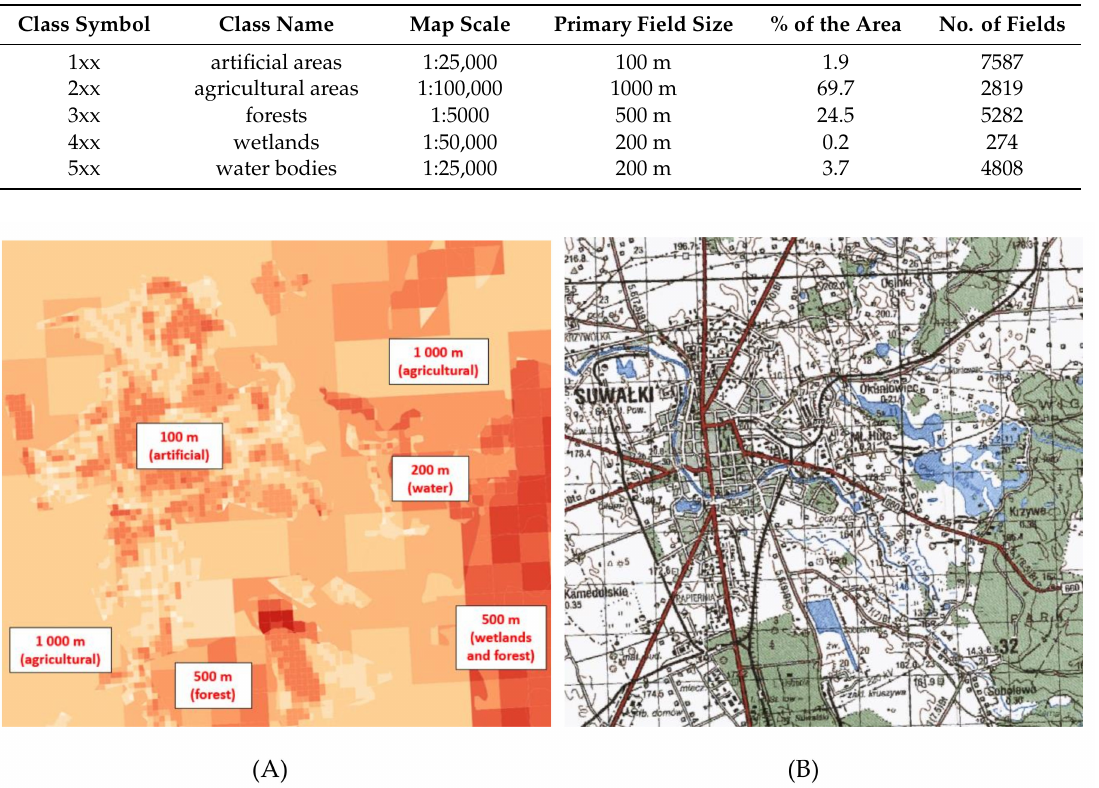
Figure 5. Visualization of the distinguished classes of Corine Land Cover ( A ) and its comparison with the content of the map ( B